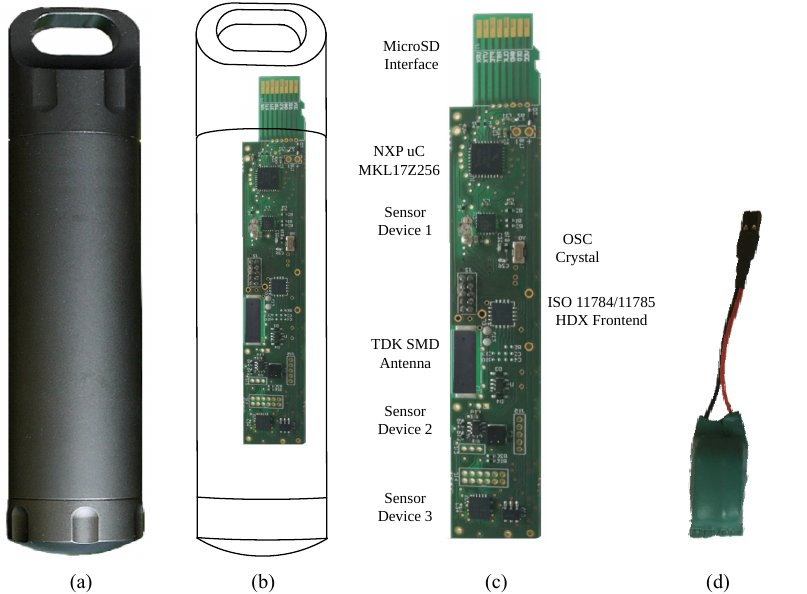
Figure 10. Underwater sensor node: ( a ) capsule, ( b ) comparison of capsule and main board sizes, ( c ) main board details, and ( d ) battery.